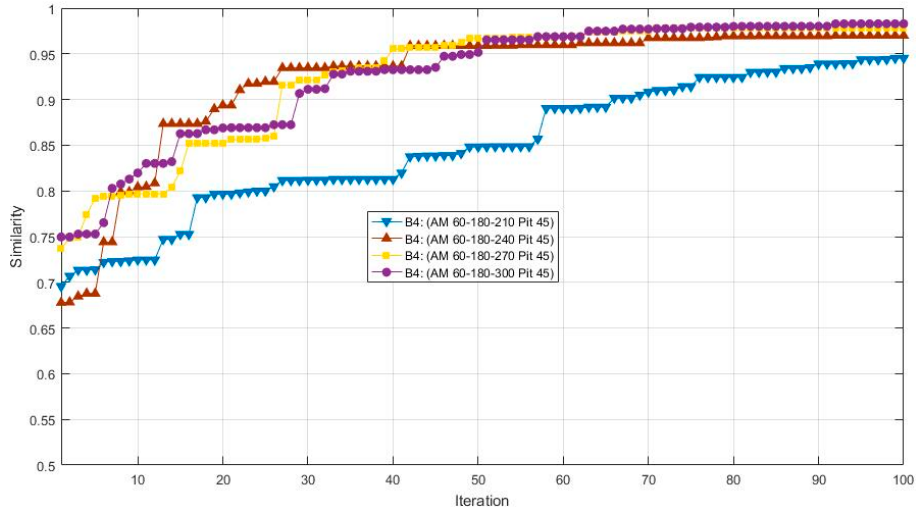
Figure 8. The results of cases (60-180-X, 45) in 100 iterations.